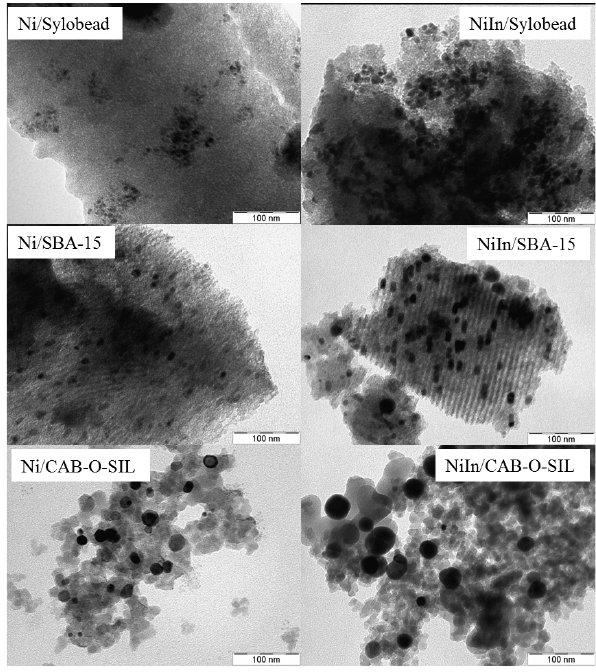
Figure 8 : The evolution of active metallic phases reflected by the selected HT-XRD patterns of indium free Ni/SiO catalyst precursors 2 Figure 10 : TEM images of the mono- and bi-metallic catalysts after (a, b) and of Ni/SiO admixed with 10% In O (A, B, C) reduced in H 2 2 3 2 treated in H flow for 30 min at flow step by step for 30 min at 200 (a, A), 450 (b, B) and 650°C (C). 2